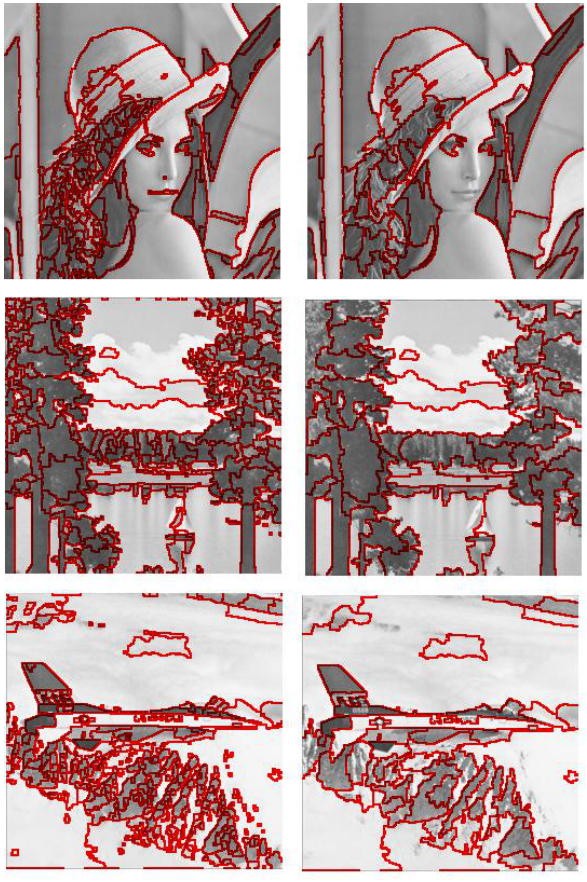
Fig 8. The results of three images “Lena”, “Lake” and “Jet” from top to bottom. The left column is segmentation results after stage 1, the improved watershed transform, and the right column is the results after stage